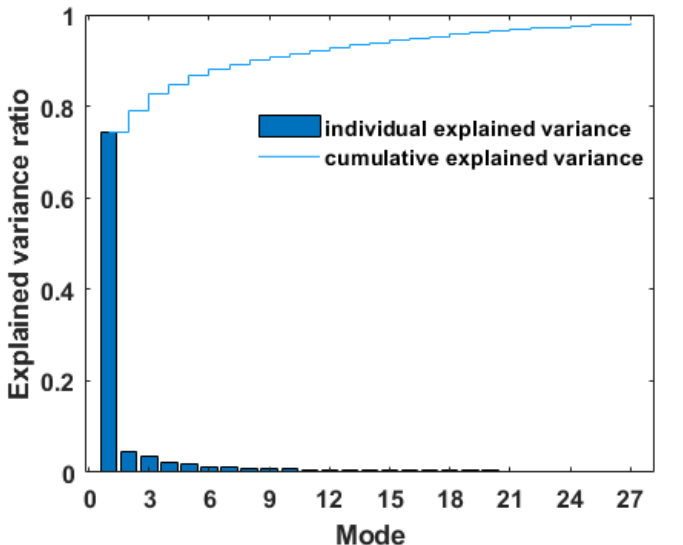
Figure 7. Explained variance of the first 28 CSEOF modes with cumulative explained variance of 98%.